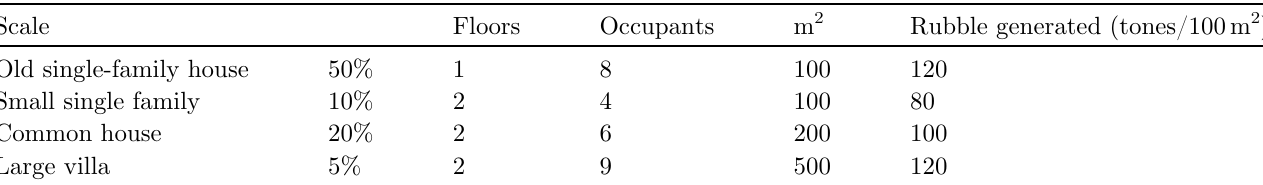
Fig. 9. Left (cid:1) Mosul church (Al Saah Church) destruction [Mosul Eye]; Right: Unprotected historical materials and elements [Reuters]. Table 2. Residential building types in the Old City.